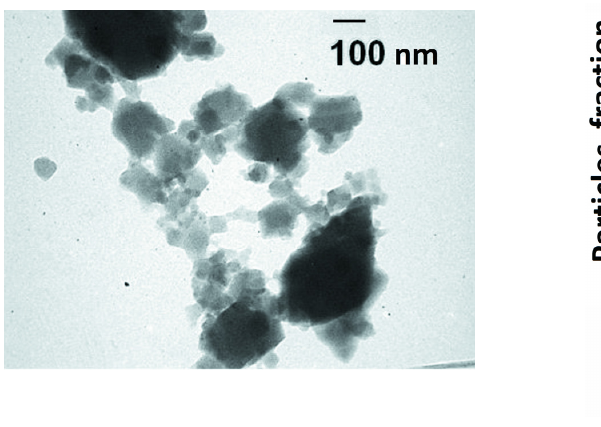
Figure 2. TEM image ( a ) and particle size distribution ( b ) for HKUST-1 used in this study.